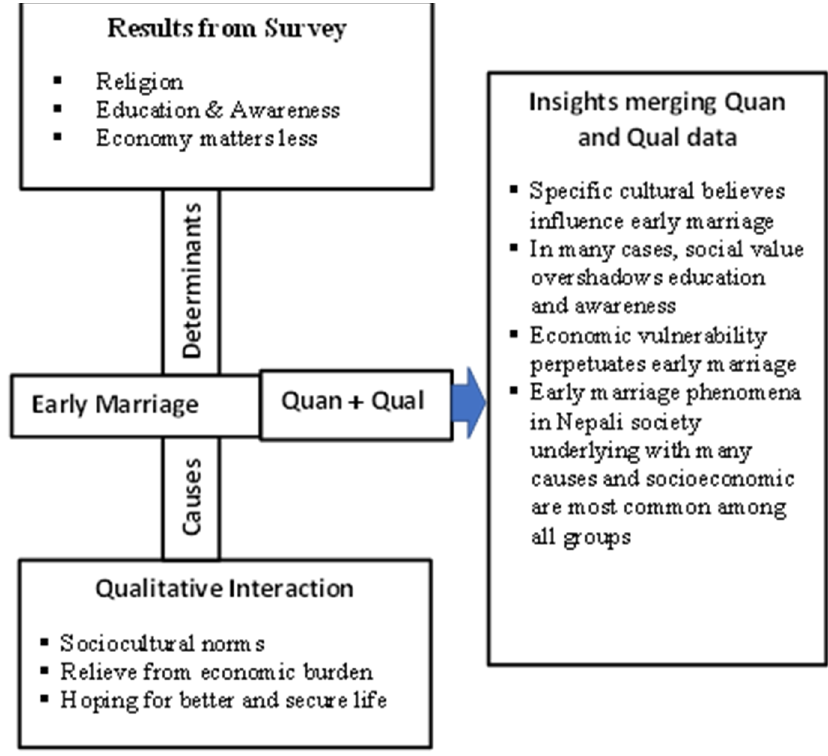
Figure 1. Joint Display: Merging Quantitative and Qualitative Results. Quan = quantitative strand; Qual = qualitative strand.